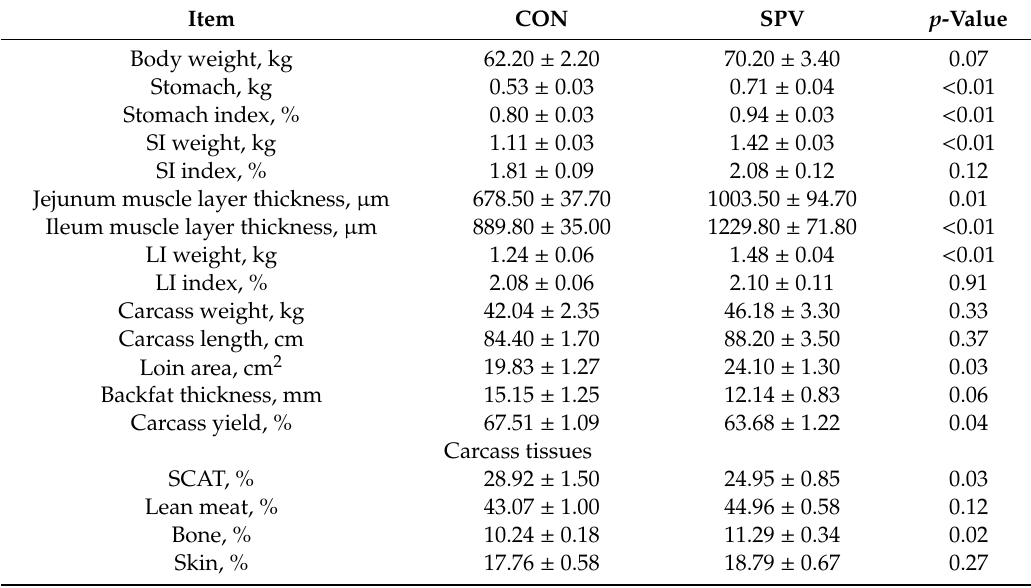
Table 2. E ff ect of the sweet potato vine treatment on visceral weight and body composition by manual